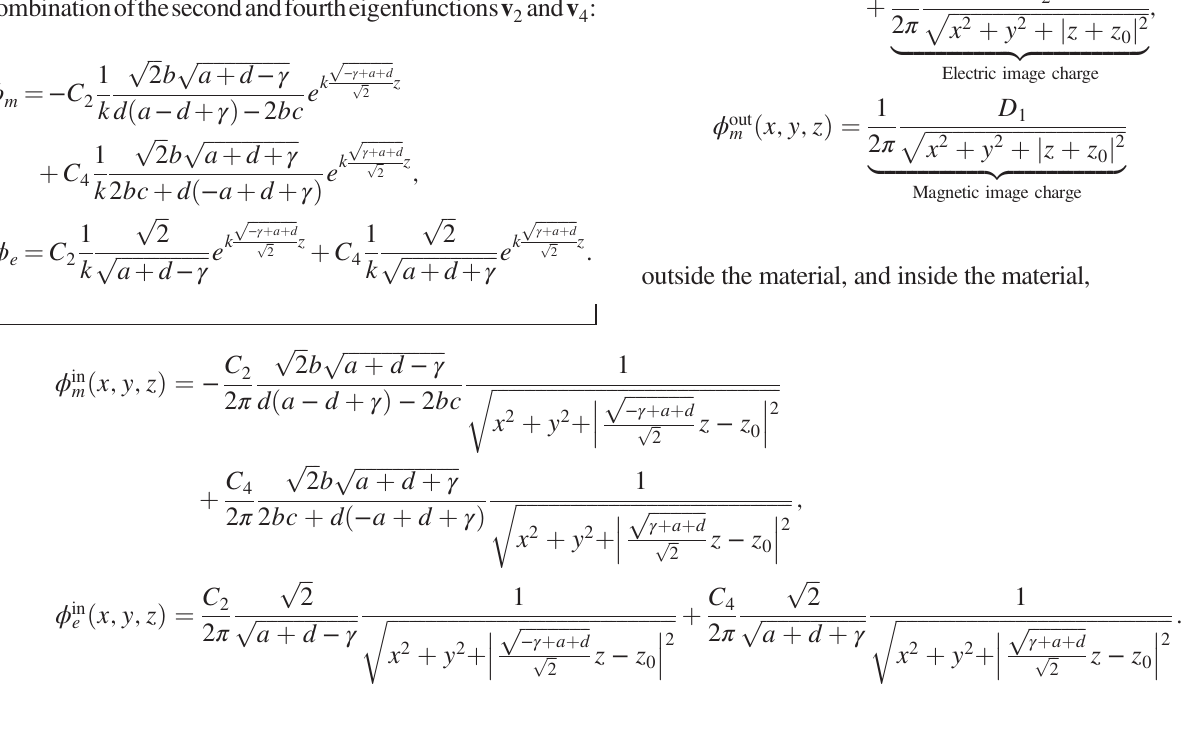
ffiffiffiffiffiffiffiffi p ffiffi γ þ a þ d 2